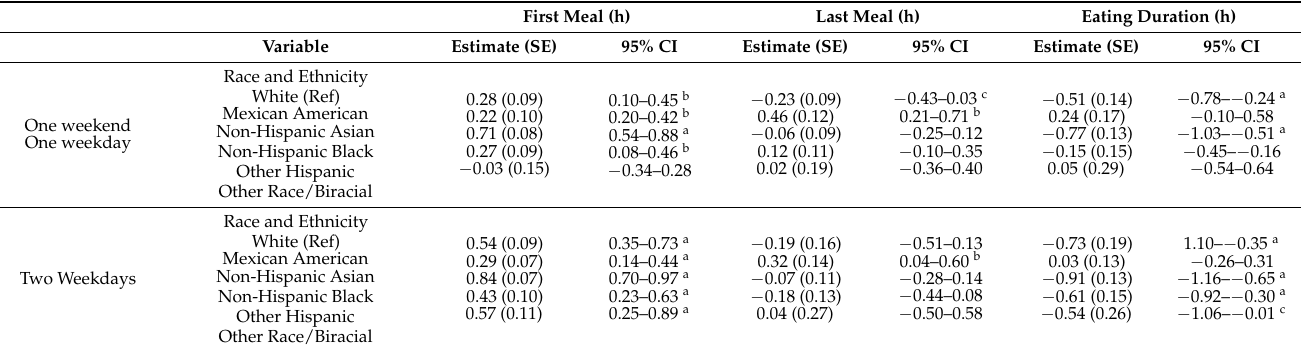
Table 3. Multiple Linear Regression Models for First Meal, Last Meal, and Eating Duration, NHANES 2011–2018 stratified by dietary recall